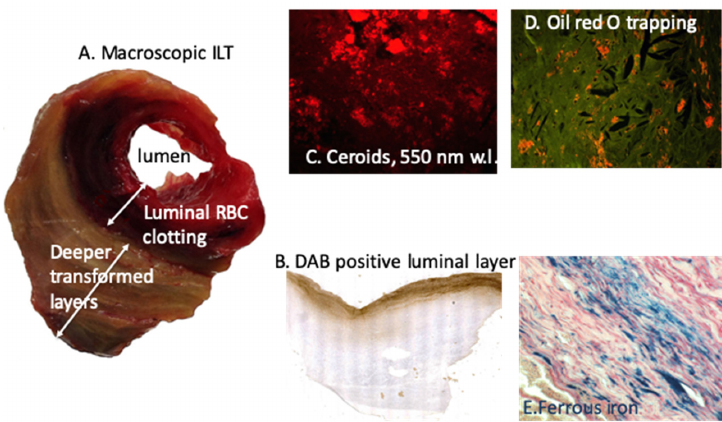
Figure 4. RBC-dependent oxidative stress in AAA: ( A ) macroscopic luminal view of the thrombus, with a predominant RBC fresh clotting at the interface with circulating blood; ( B ) diaminobenzidin (DAB) staining of RBC in the most luminal layer; ( C ) autofluorescent ceroids (550 nm), the wavelength of Hb; ( D ) oil red O staining of lipids (orange color); and ( E ) Perl’s blue staining of Fe +++ , the storage redox inactive form of iron, bound to ferritin and transported by transferrin